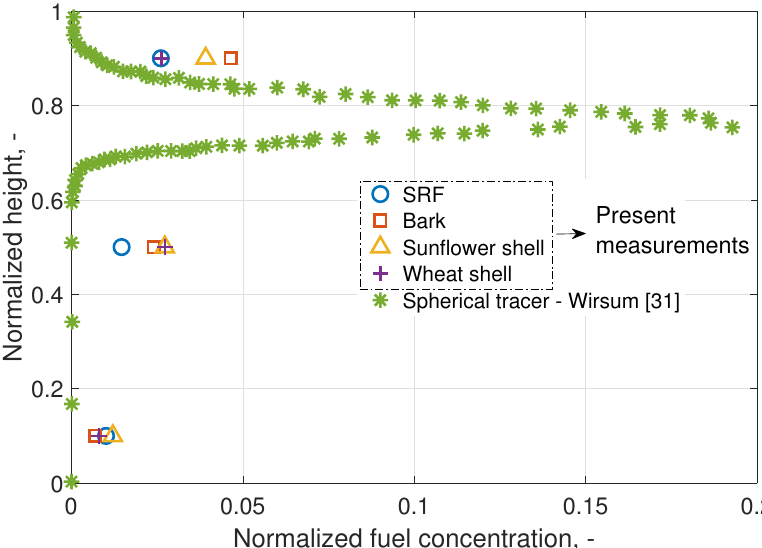
Figure 10. Comparison among the vertical concentrations of the investigated active particles and the spherical tracer [31] in the bubbling fluidized bed. ( u g / u mf = 1.6 “present measurements”, u g / u mf = 1.52 “Wirsum [31]”. The percentage errors of the present concentration results are ± 12.5% at the bottom, ± 8.3% in the bed body, and ± 50% on the top